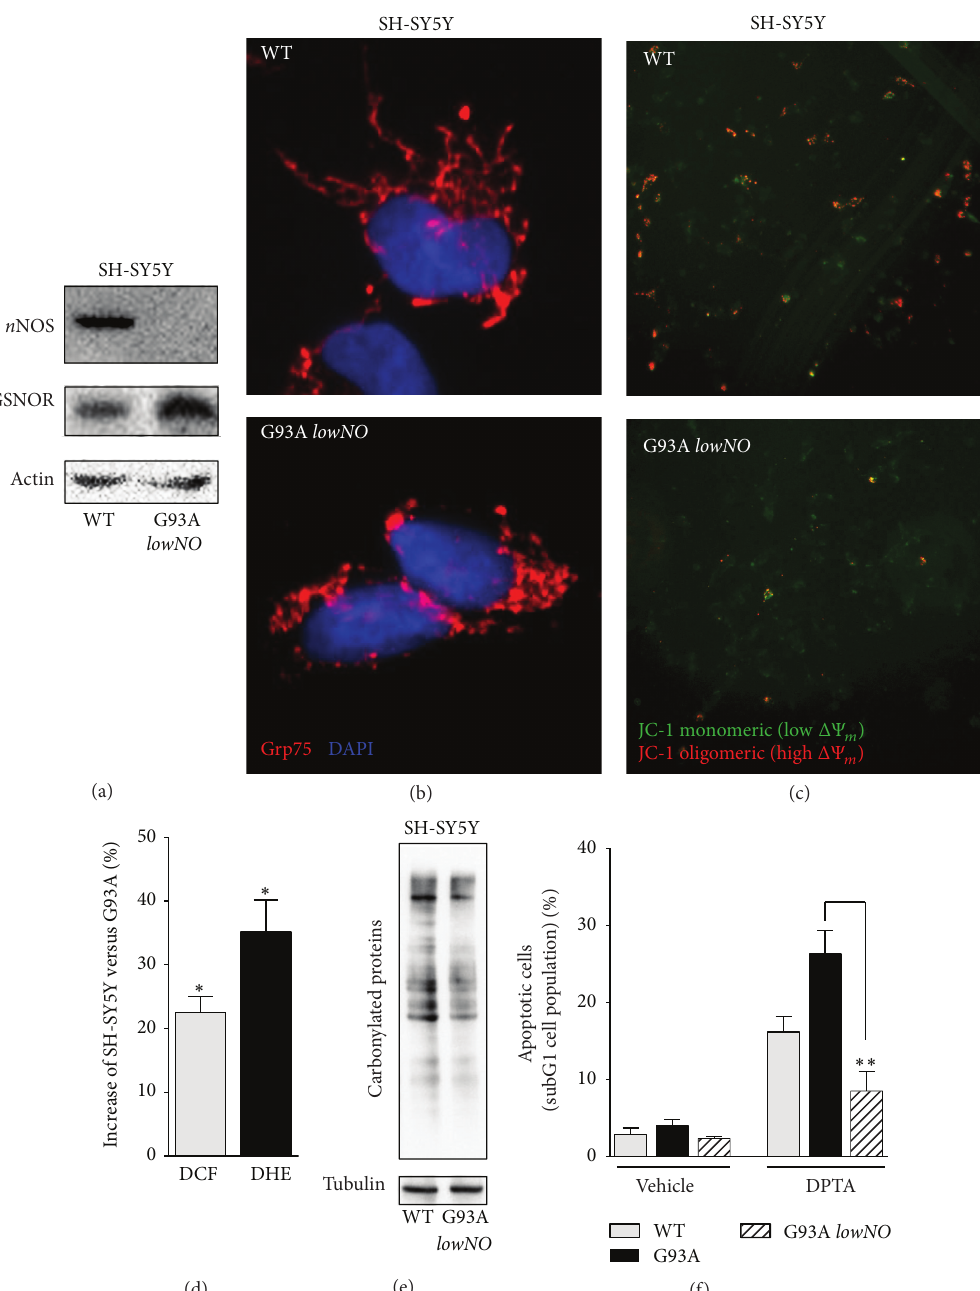
Figure 7: Characterization of the lowNO G93A resistant clone. (a) Western blotting of n NOS and GSNOR in total cell lysates of parental SH-SY5Y (WT) and the resistant lowNO G93A clone. (b) Fluorescence microscopy analyses of parental SH-SY5Y (WT) and the lowNO G93A clone. Anti-Grp75 (red) and Hoechst 33342 were used to visualize mitochondria and nuclei, respectively. (c) Fluorescence microscopy analyses of mitochondrial transmembrane potential ( Δ𝜓 𝑚 ) of WT and the lowNO G93A clone by JC-1. Red fluorescence, high Δ𝜓 𝑚 and green fluorescence, low Δ𝜓 𝑚 . (d) Cytofluorimetric analyses of H 2 O 2 and O 2∙− in SH-SY5Y (WT) and the lowNO G93A clone upon 2 󸀠 ,7 󸀠 - dihydrodichlorofluorescein (DCF) or (c) dihydroethidine (DHE) staining. (e) Western blot analyses of protein carbonyls from total cell lysates obtained from WT and the lowNO G93A clone. (f) Cytofluorimetric analyses of apoptosis upon propidium iodide staining performed on parental SH-SY5Y cells (WT), sensitive G93A, and the lowNO G93A clone treated for 24h with 400 𝜇 M DPTA. Western blots shown are representative of at least 𝑛 = 3 independent experiments that gave similar results. Actin or tubulin was selected as loading controls. Graphs shown represent the mean of data ± SD of 𝑛 = 3 independent experiments, ∗ 𝑃 < 0.05 with respect to trigonelline untreated